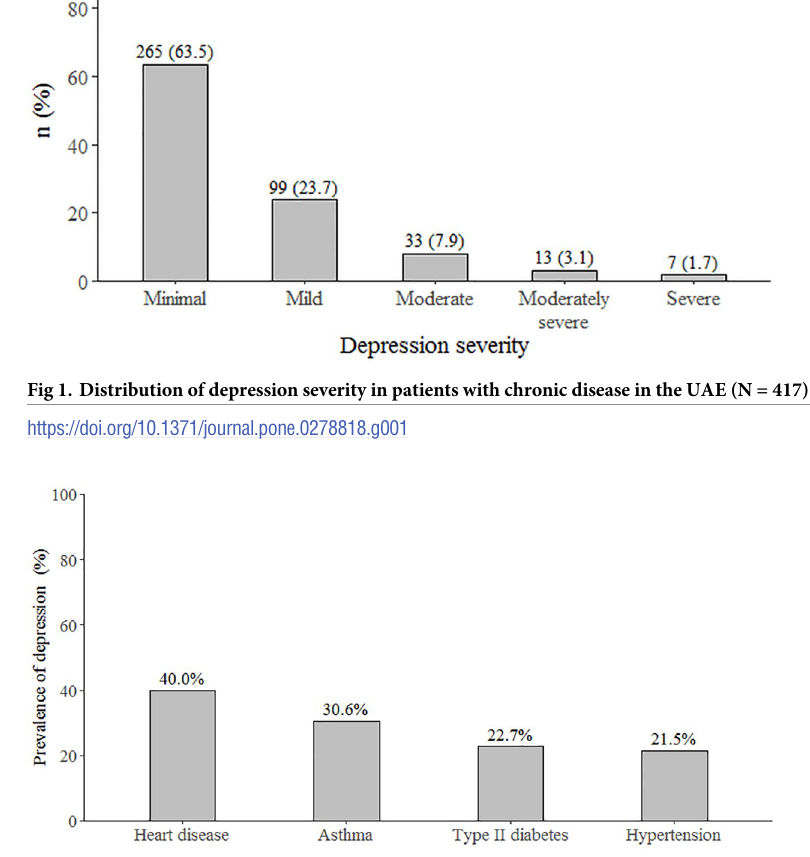
Fig 2. Depression prevalence in selected chronic